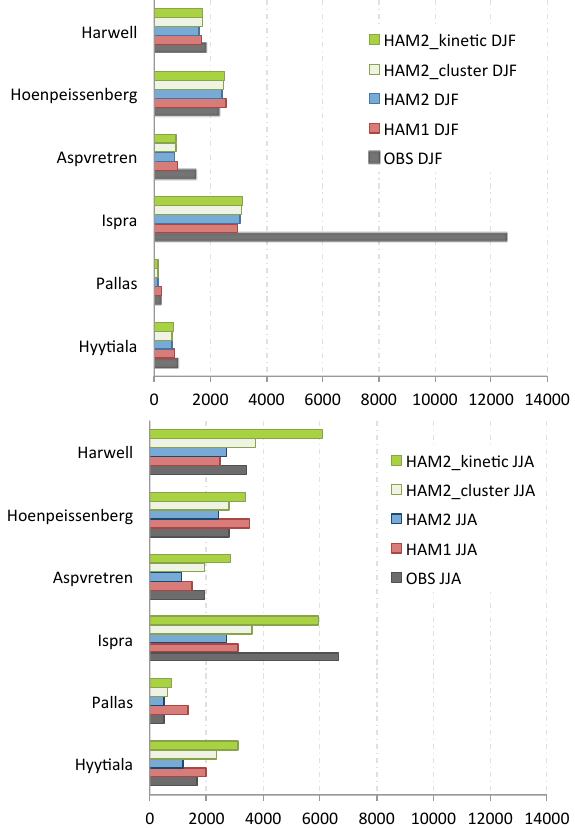
Fig. 13. Simulated and measured aerosol number concentration (cm − 3 ) in the planetary boundary layer at various continental sites. The observational data are from Putaud (2003) and Tunved et al. (2003). The corresponding particle size distributions are shown in Figs. 14 and